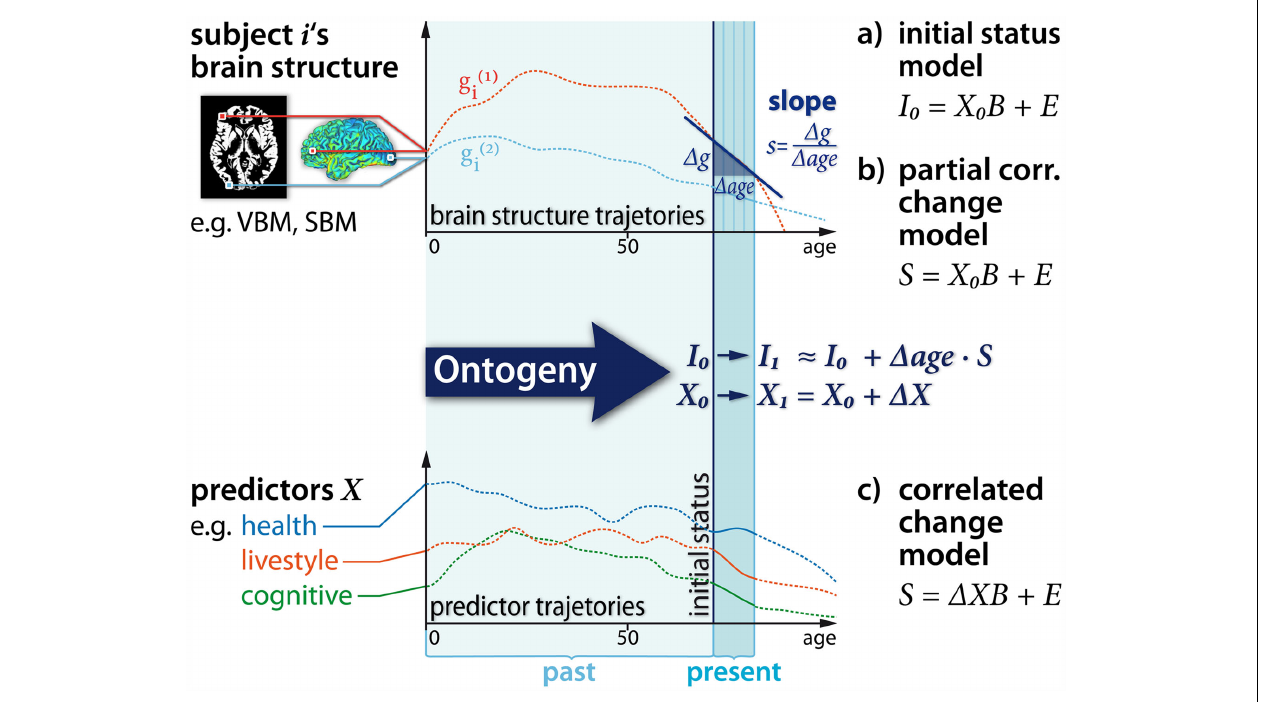
FIGURE 7 | Illustration of analysis of inter-individual variability in longitudinal structural brain imaging studies. Brain level (top): we show the individual subject’s local lifespan trajectories and the longitudinal sampling with baseline MRI and four annual follow-ups. A linear approximation of the trajectories reveals individual change parameters, namely the initial status I 0